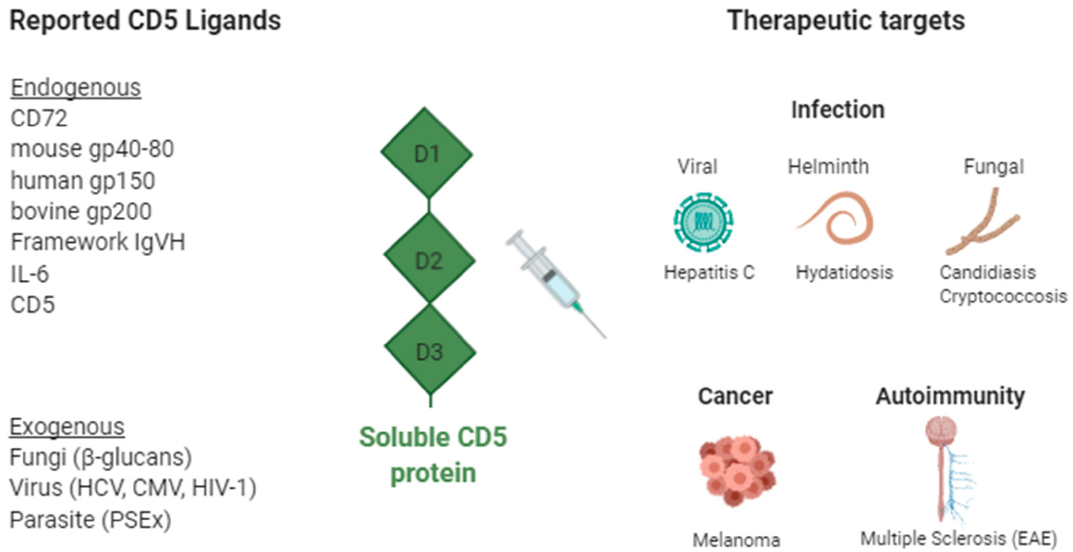
Figure 1. Soluble CD5 decoy receptor-based therapeutic strategies in infection, autoimmunity, and cancer. Reported CD5 ligands and their therapeutic targets. CD, cluster of differentiation; gp, glycoprotein; IL, Interleukin; IgVH, immunoglobulin heavy-chain variable; HCV, hepatitis C virus; CMV, cytomegalovirus; HIV, human immunodeficiency virus; Created with BioRender.com.